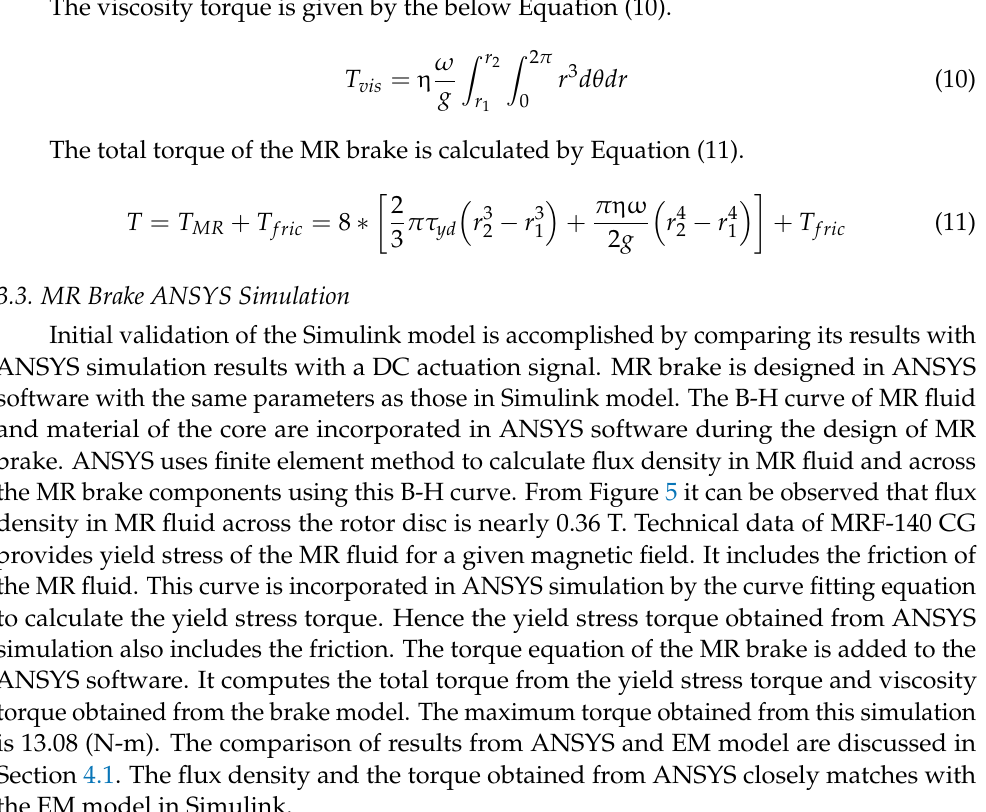
The viscosity torque is given by the below Equation (10).